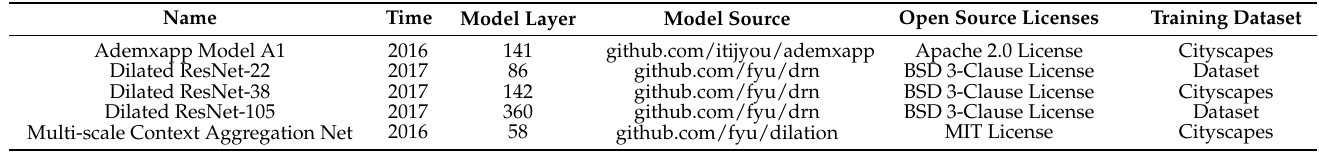
Table 2. The information regarding the different CNNs.